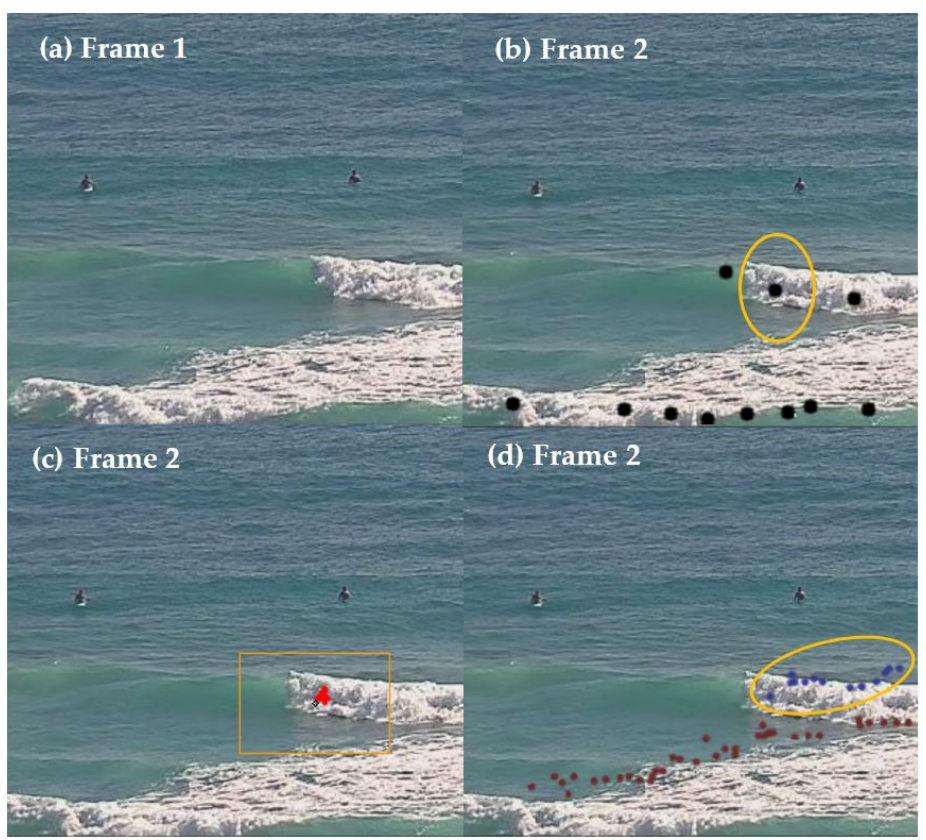
Figure 2. Sequence of images showing WPT algorithm. ( a ) Frame 1, to be compared with frame 2. ( b ) Frame 2 with potential wave peel region centres plotted as black dots. ( c ) Frame 2 with a classified wave peel region lining up with the circled dot in ( b ). ( d ) Frame 2 with plotted historical WPTs. The classified wave peel region in ( c ) was assigned to the blue track, which was closest in time and space. The distance and elapsed time are represented by the cost function in Equation